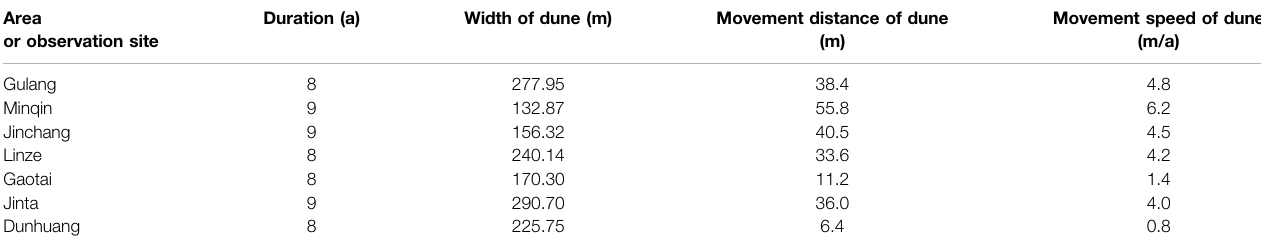
TABLE 3 | Annual movement distance and speed of sand dunes in the Hexi Corridor. Data from Shi et al. (2018). Area Duration (a) Width of dune (m) Movement distance of dune or observation site